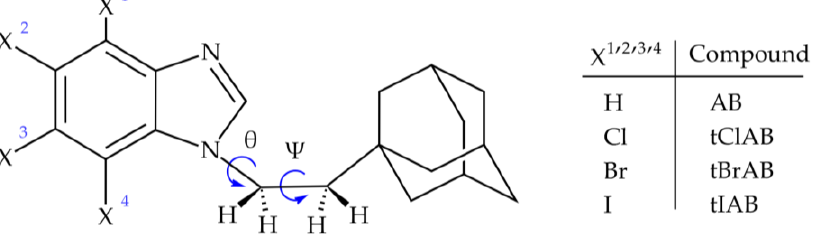
Figure 1. Structural formula of adamantylated 4,5,6,7-tetrahalogeno-1 H -benzimidazoles, (torsion angles: ψ = ∠ C(2)N(1)C(10)C(11) and θ = ∠ N(1)C(10)C(11)C(12)).